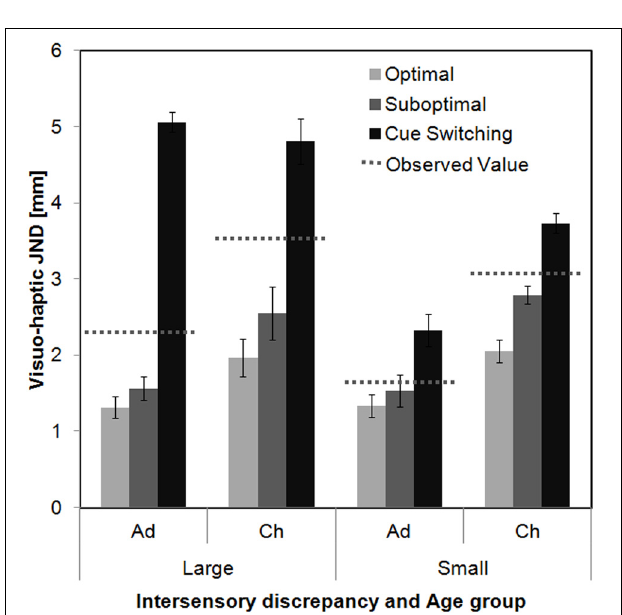
FIGURE 4 | Average predicted visuo-haptic JND values and standard errors as a function of Intersensory discrepancy and Age group (Ad[ults] vs. Ch[ildren]) collapsed over Stimulus sets. The dotted lines represent the observed visuo-haptic JNDs.